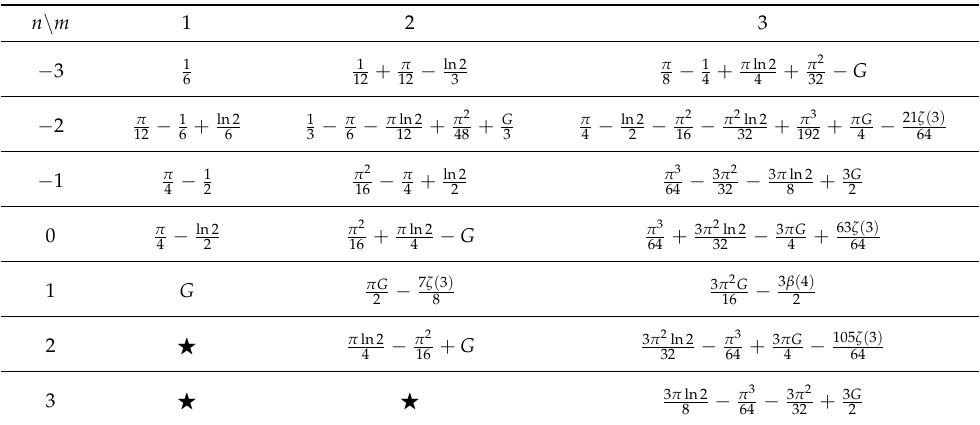
Table 2. Values for T ( m , n )